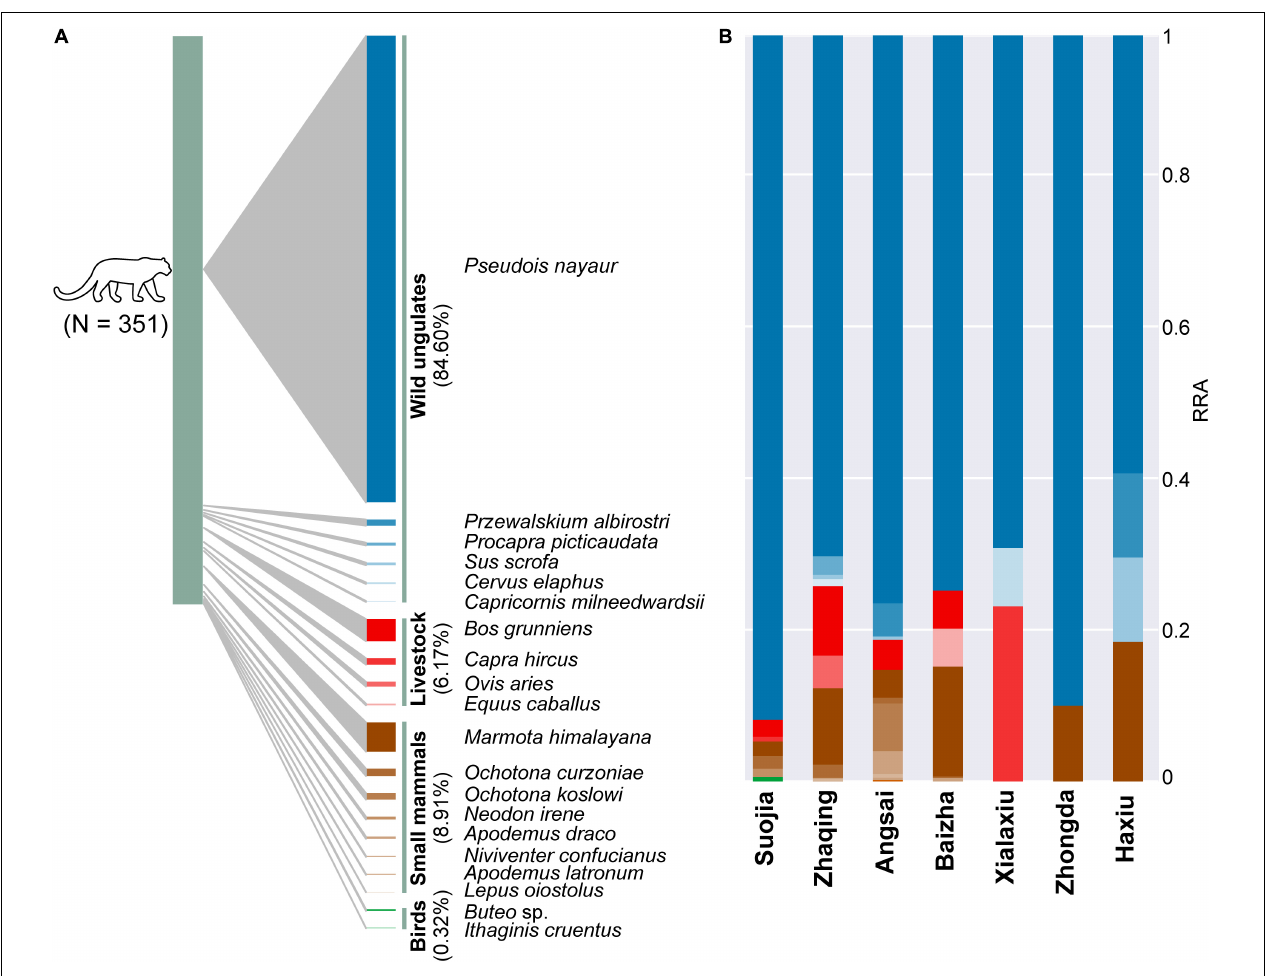
FIGURE 2 | Dietary composition of the snow leopard in Sanjiangyuan on the Qinhai-Tibetan Plateau. Proportional representation of relative read abundance (RRA) of vertebrate prey in (A) all snow leopard samples and (B) in the diets at each sampling